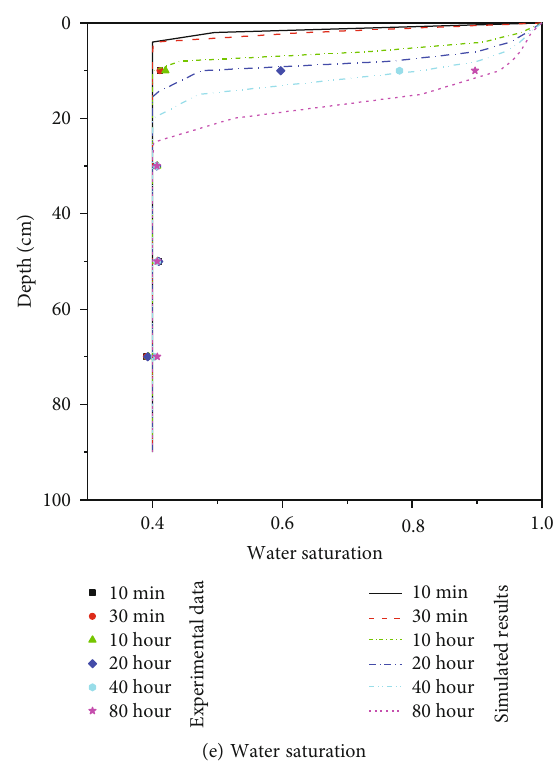
Figure 2: Calculation model and results for the rainfall in fi ltration